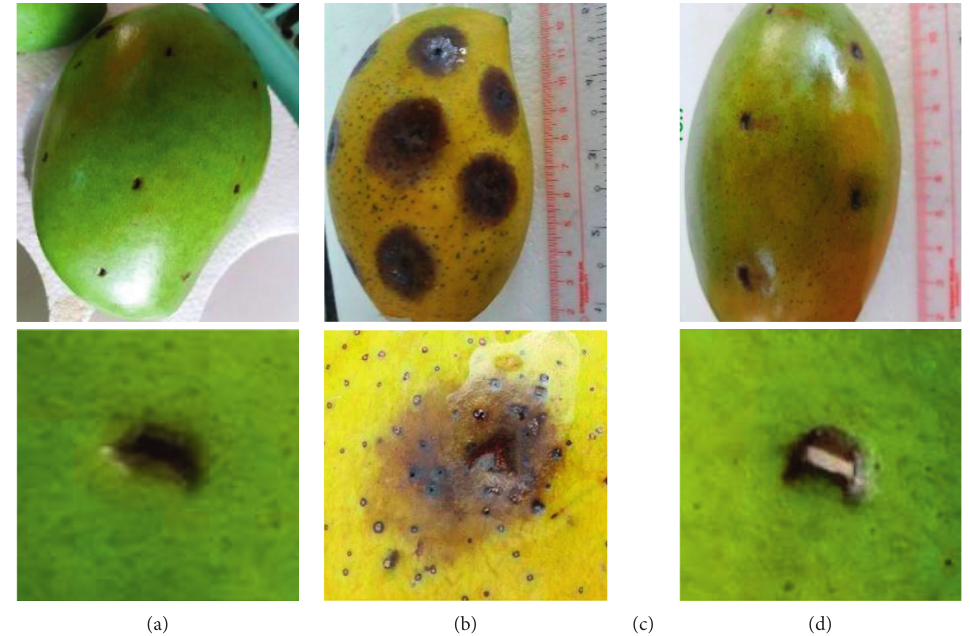
Figure 10: In vivo antifungal test against C. gloeosporioides on the surface of mango: A1: 0 th day, CuNPs; B1: 4 th day, no coating; C1: 4 th day, control coating (without CuNPs); D1: 4 th day, coating with CuNPs. A2, B2, C2, D2 are magnified images of wounds in the A1, B1, C1, D1 figures,